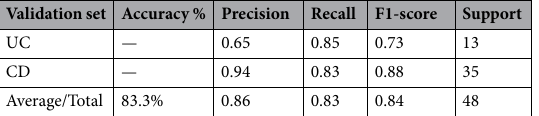
Validation set Accuracy % Precision Recall F1-score Support